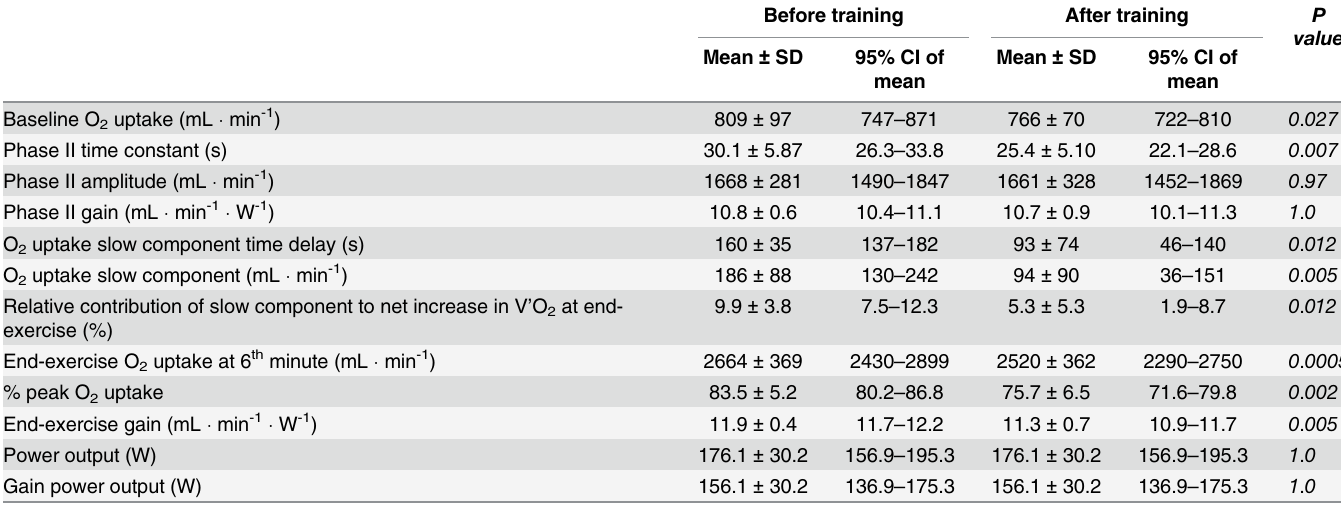
Table 3. Oxygen uptake on-kinetics during high-intensity cycling exercise, before and after 20 weeks of training.